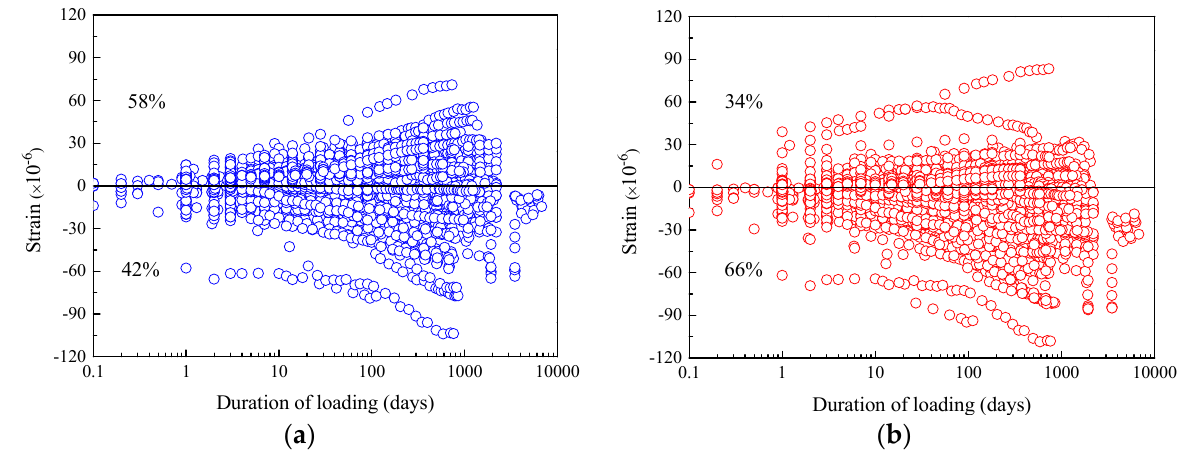
Figure 5. The residuals of creep compliance for CEB-FIP models versus time. ( a ) Residuals for CEB-FIP1990 model. ( b ) Residuals for CEB-FIP 2010 model. Table 4. Distribution of creep compliance residuals for CEB-FIP 1990 and 2010 shrinkage models.